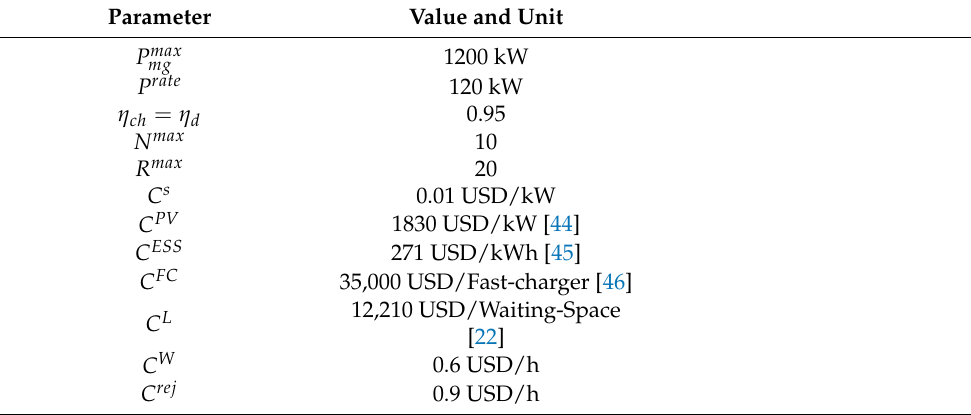
Table 2. Parameters for the